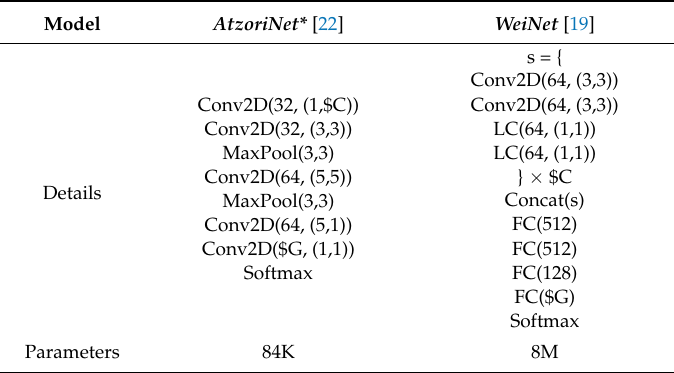
Figure A9. f1 scores of the AtzoriNet* for each gesture of putEMG dataset for τ = 1 and R = 15. Table A1. Architecture details of the two CNN